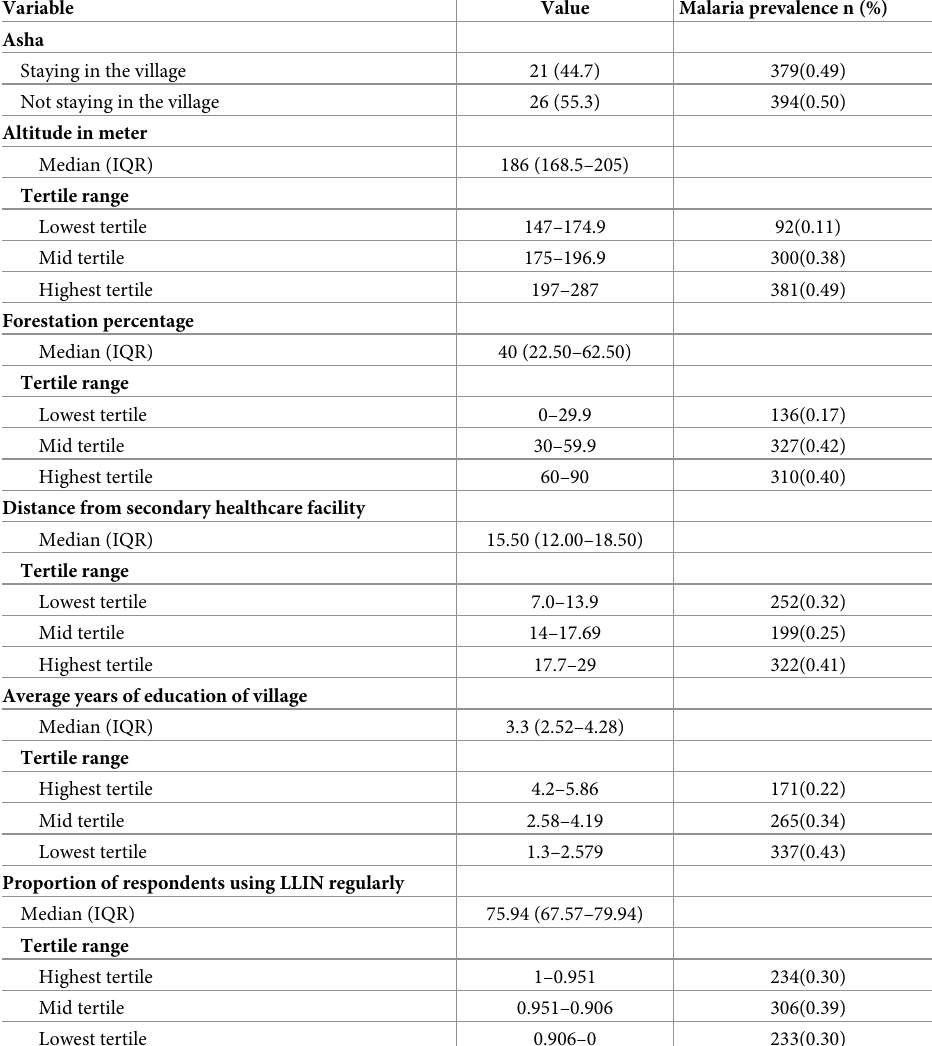
Table 1. Principal explanatory